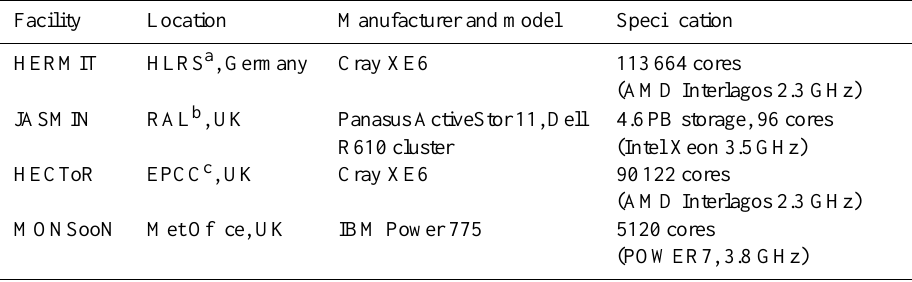
Table 1. Facilities used in